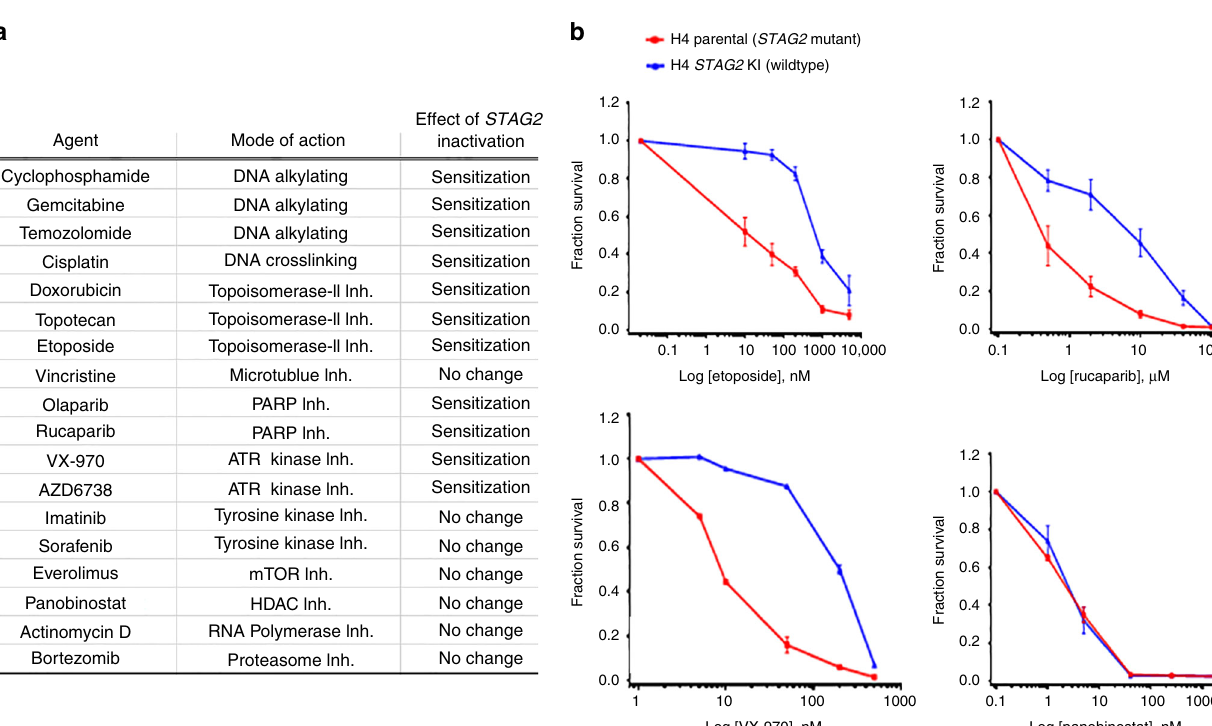
Fig. 8 STAG2 de fi cient cancer cells harbor increased sensitivity to cytotoxic chemotherapeutic agents and small molecule inhibitors of DNA double-strand break repair. a Summary of results from chemotherapeutic screen in four pairs of STAG2 isogenic human cells (H4 glioblastoma, 42MGBA glioblastoma, TC-106 Ewing sarcoma, and RPE hTERT sh TP53 ). All four pairs showed similar sensitivities for all agents. b Survival plots of STAG2 isogenic H4 glioblastoma cells following treatment with etoposide (topoisomerase II inhibitor), rucaparib (PARP inhibitor), VX-970 (ATR inhibitor), and panobinostat (HDAC inhibitor). Each data point is the mean of 12 replicates from 3 independent experiments, and error bars show standard error of the mean. Source data are provided as a Source Data fi le whereas the interaction with other replisome components including CDC45 and AND1 remains stable. These fi ndings indicate that the interaction of the cohesin ring with the pre- replication complex and the active replication machinery during S phase is a complex and dynamic process, which is perturbed by the absence of STAG2. We speculate that the binding of cohesin with Geminin may represent a critical mediator of an intra-S- phase checkpoint to ensure establishment of sister chromatid cohesion during DNA replication. The disruption of cohesin binding with the replication factors PCNA, PolD, and PolE upon STAG2 depletion may represent either lack of recruitment to the active replication fork or instability and dissociation from the stalled replication fork. Regardless of the mechanism, this results in stalling of DNA synthesis, accumulation of single-stranded DNA binding protein RPA2/p34 at replication sites, and even- tually fork collapse (Fig. 9). NATURE COMMUNICATIONS| (2019) 10:1686